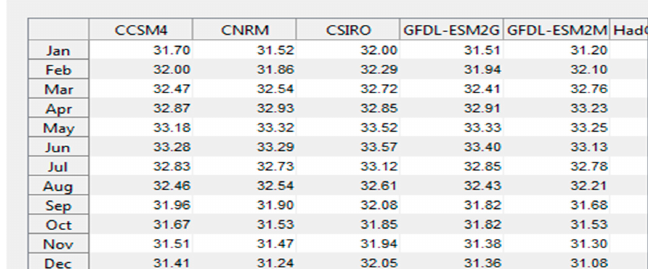
Figure 10. Example of the mean monthly changes in future temperature maximum (tmax) under the RCP45 scenario generated from the interface.